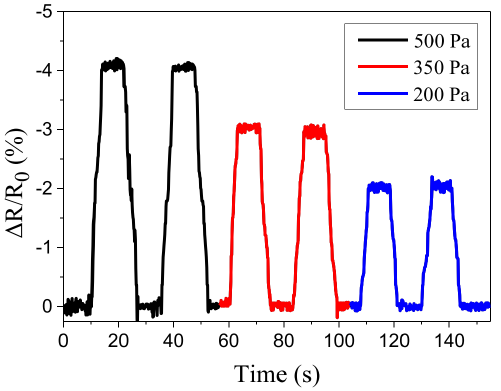
Figure 9. The response of the sensor under periodic loading and unloading cycles.